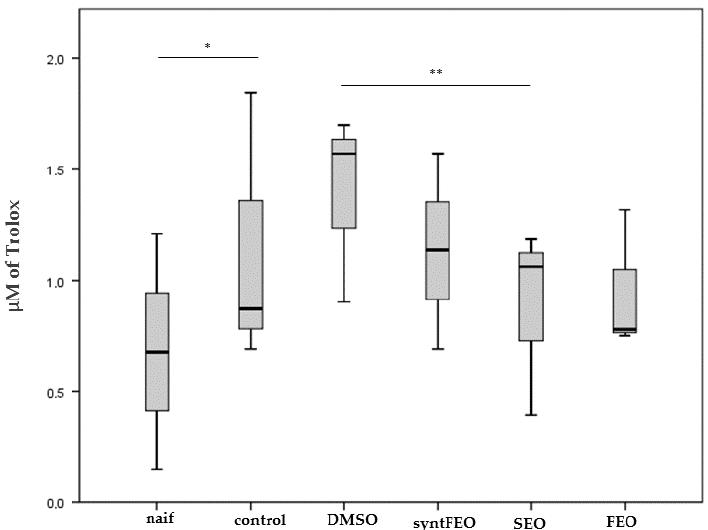
Figure 5. TAA measured in 2 mL of ABTS solution in the presence of 50 µ L of supernatant obtained after incubation of pre-adipocytes for 24 h in the presence of 1 µ M of synFEO dissolved in DMSO. FEO was diluted in DMSO and normalized to 1 µ M in thymoquinone content. SEO was added to cell suspension using the same volume used for FEO sample. The decrease in absorbance at 734 nm is referred to a standard curve obtained by using known concentrations of Trolox. * p < 0.05 ** p <